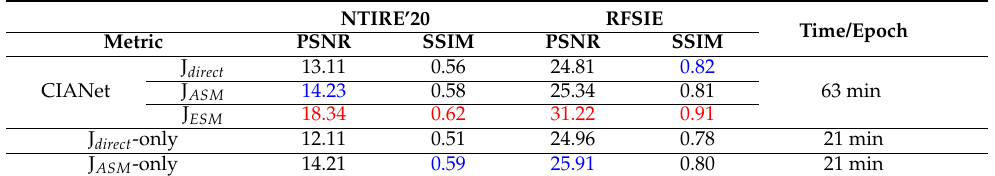
Table 3. Average PSNR (dB) and SSIM results of different outputs from CIANet on RFSIE and NTIRE’20. The first and second best results are highlighted in red and blue.